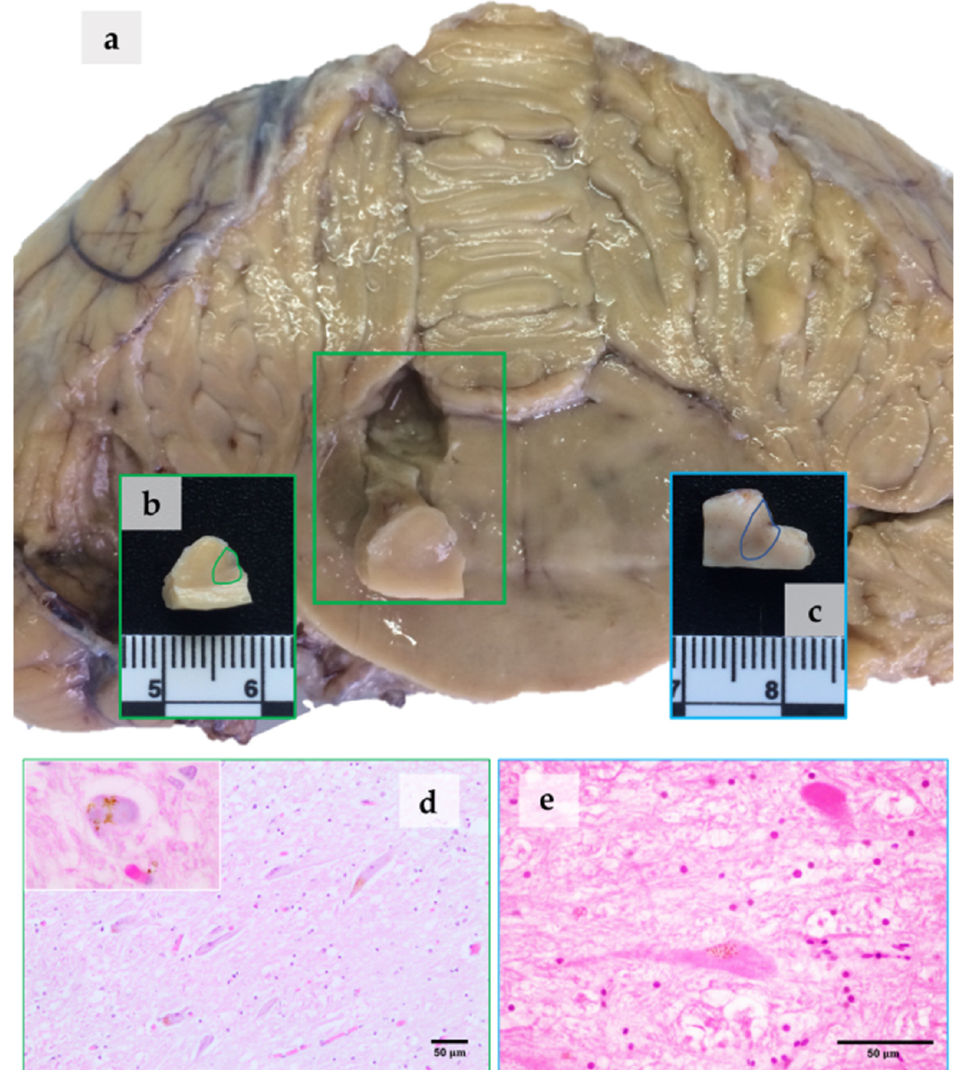
Figure 1. Sampling of the LC and presence of NM. ASD, blue boxes; BBW, green boxes. Samples were taken from the LC at the level of the metencephalon ( a ), and more exactly from the A6d and A6v subdivisions (( b , c ), marked areas). In the ASD, the LC can be seen macroscopically as a darkened area (( c ), marked area). Neuromelanin in LC perikaryal cytoplasm, observed as light brown granular material. Hematoxylin and eosin staining ( d , e ). Inset: round pale basophilic inclusions in LC neuronal perikaryon, pushing NM to the periphery. BBW ( d ).